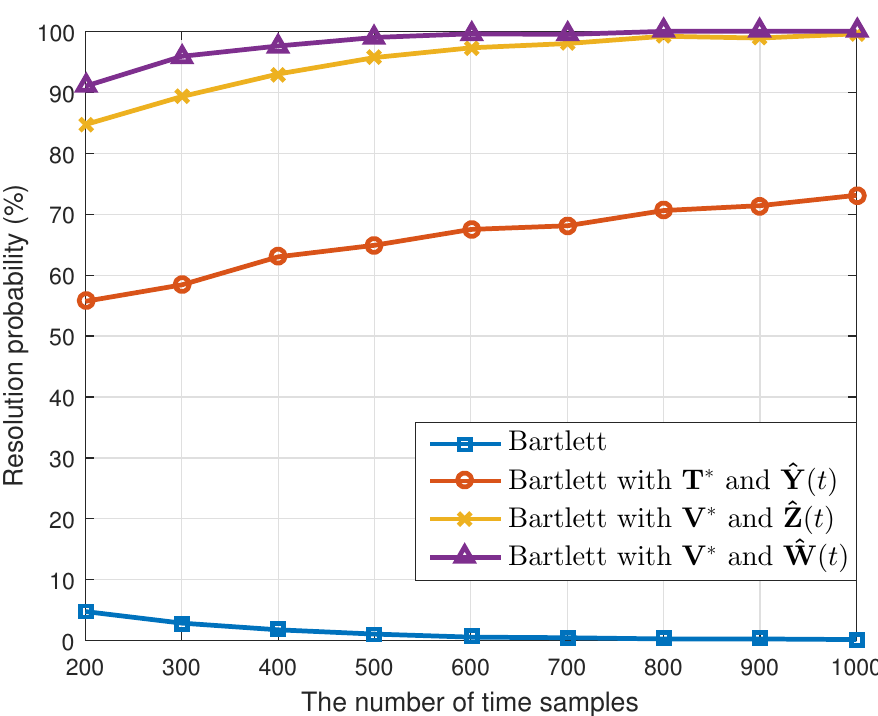
Figure 5. Resolution probabilities versus the number of time samples (SNR is 10